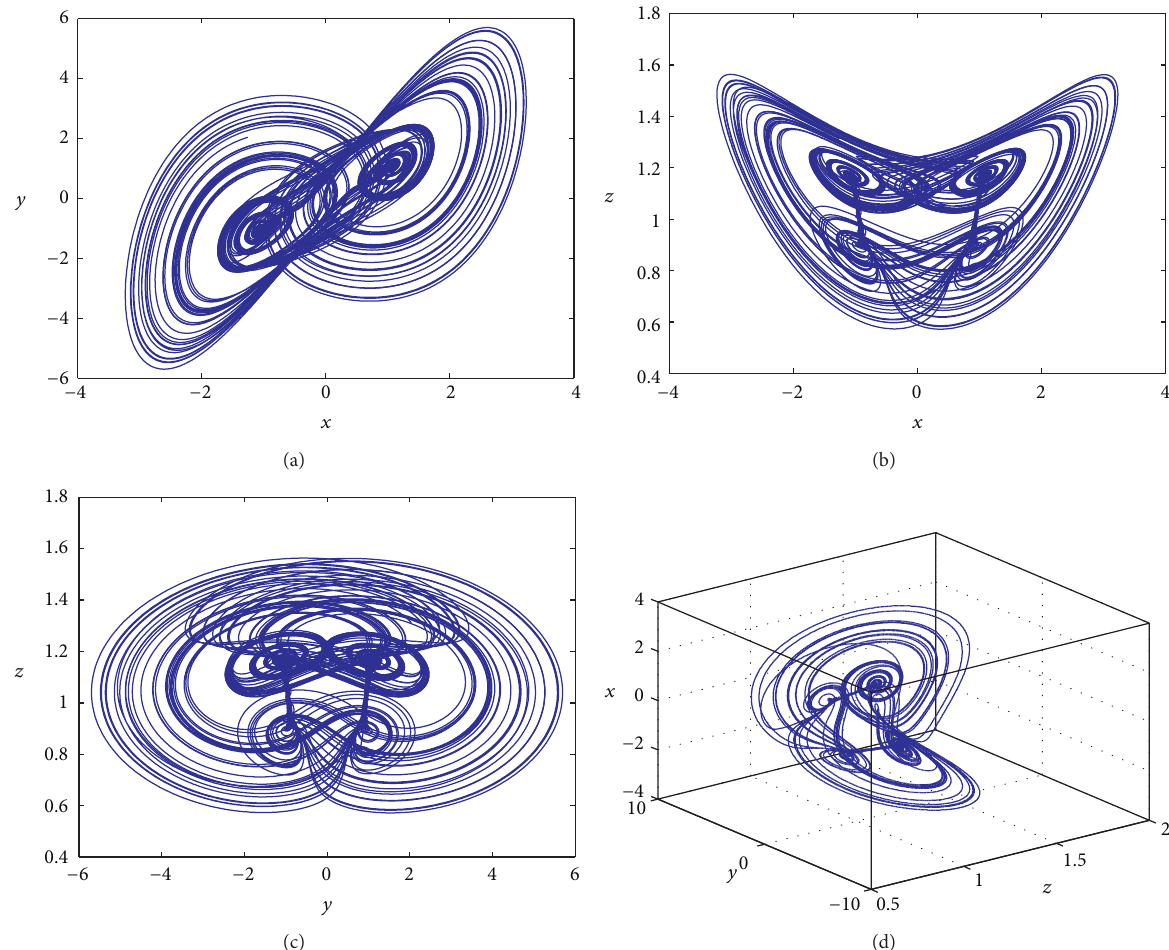
Figure 1: Phase portraits of the system (6) with 𝐴 = 0.2 , 𝜔 = 0.6 , 𝑎 = 10 , and 𝛾 = 100 : (a) 𝑥 - 𝑦 plane; (b) 𝑥 - 𝑧 plane; (c) 𝑦 - 𝑧 plane; (d) 𝑥 - 𝑦 - 𝑧